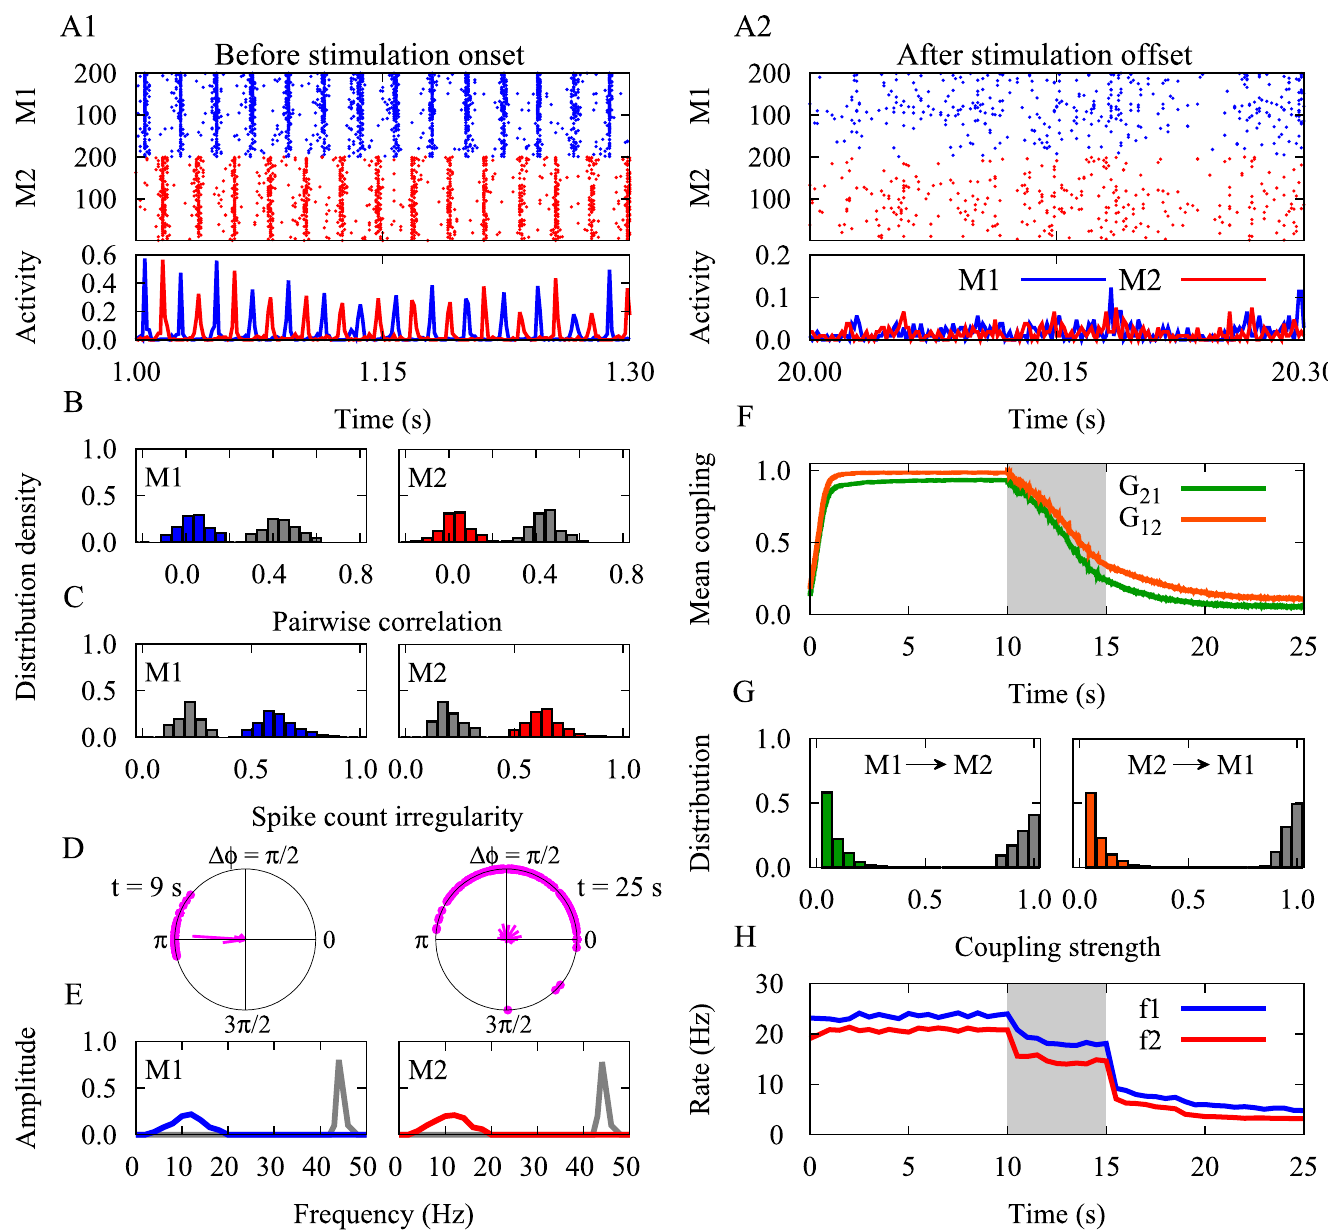
Fig 4. Decoupling by time-shifted stimulation in the network. ( A1,A2 ) Raster plots and population activities (percentage of neurons firing per time window) are shown for the modules (M1/M2) before/after stimulation on/offset. ( B,C ) Distribution of the pairwise correlation and spike count irregularity of each module before (grey) and after (colored) stimulation epoch. ( D ) Snapshot of phase lags ( Δ f ) between synchronous discharges from the two modules before t = 9 s, left) and after ( t = 25 s, right) stimulation epoch. The radial bars show the distribution of the phase lags. ( E ) Fourier transform frequency of the population activity of each module before (grey) and after (colored) stimulation epoch. ( F ) Time course of the inter-population mean coupling ( G 21 / G 12 ). ( G ) Distribution of the inter-population synaptic strengths before (grey) and after (colored) stimulation epoch. ( H ) Time course of the mean firing rates ( f 1/ f 2)of neurons in each module. The modules were stimulated with time shift Δ t = 5 ms and frequency ν = 33.3 Hz (point b in Fig 2C) for the duration of T stim = 5 s (highlighted area in F and H). The effective delay was | ξ | = 10.0 ms. STDP parameters were A + = 0.008, A − = 0.005, τ + = 10 ms and τ − = 20 ms.